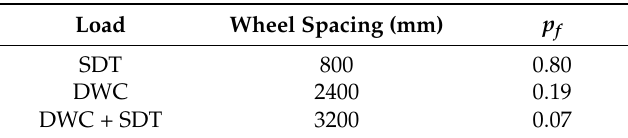
Table 9. Values of proximity